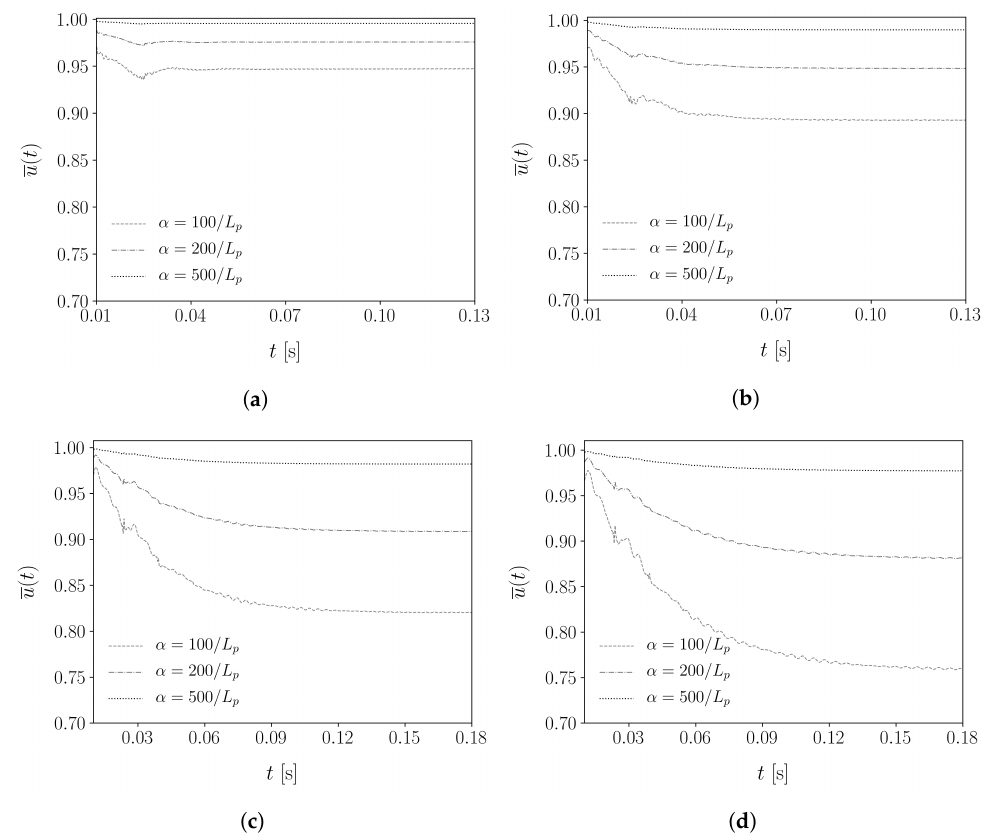
(cid:12) for a pile with l 2 = 25.2 m (cid:12) α → ∞